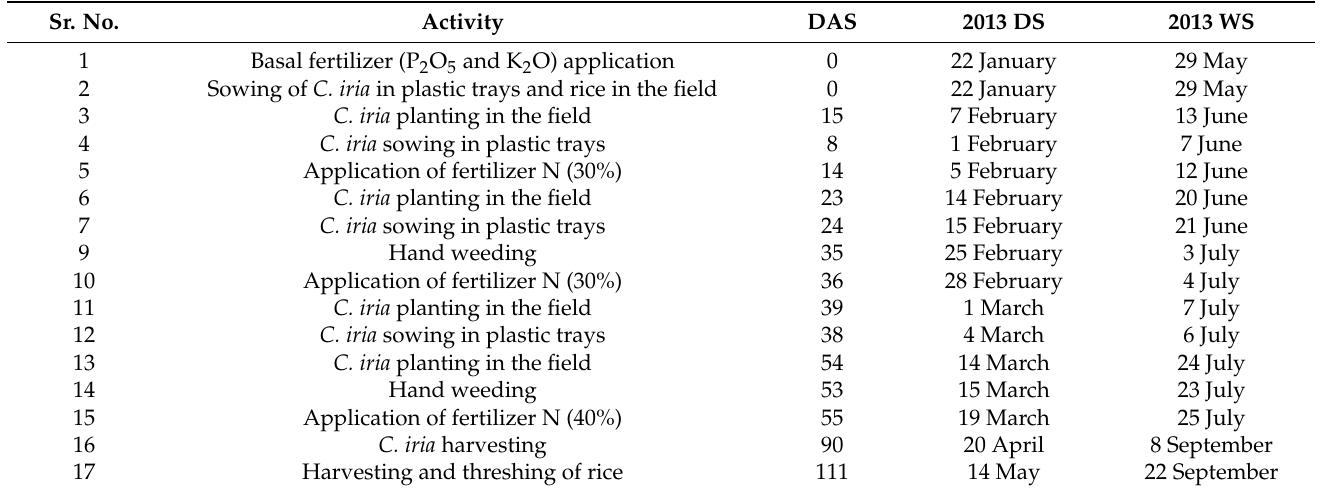
Table 1. Plan of field activities in the dry season (DS) and wet season (WS) of 2013. Sr.